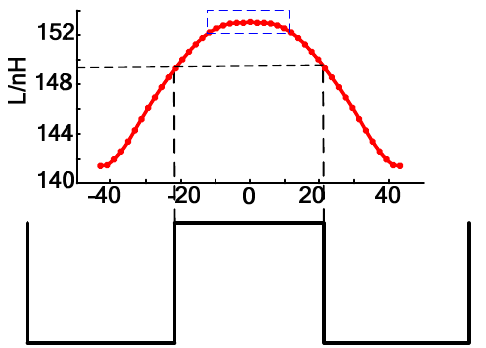
Figure 14. The relationship between coil inductance and the tooth-slot structure.